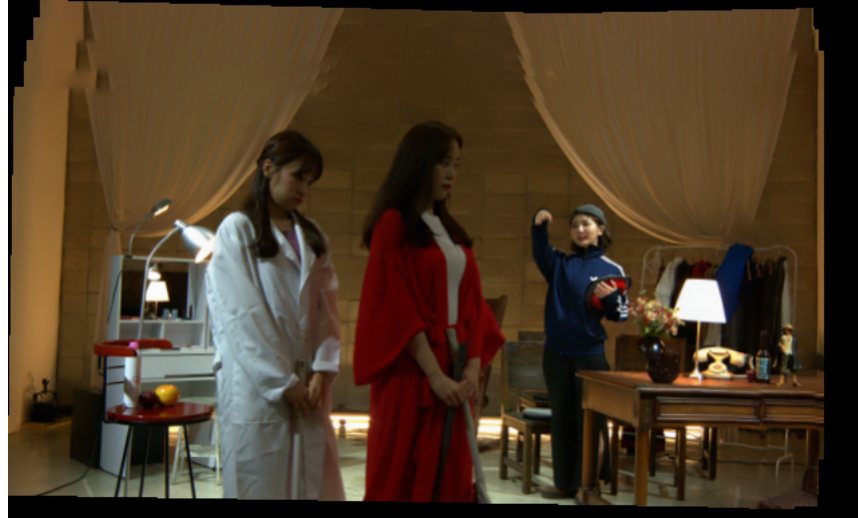
Figure 14. View synthesis with 25 images is extended in the vertical and horizontal